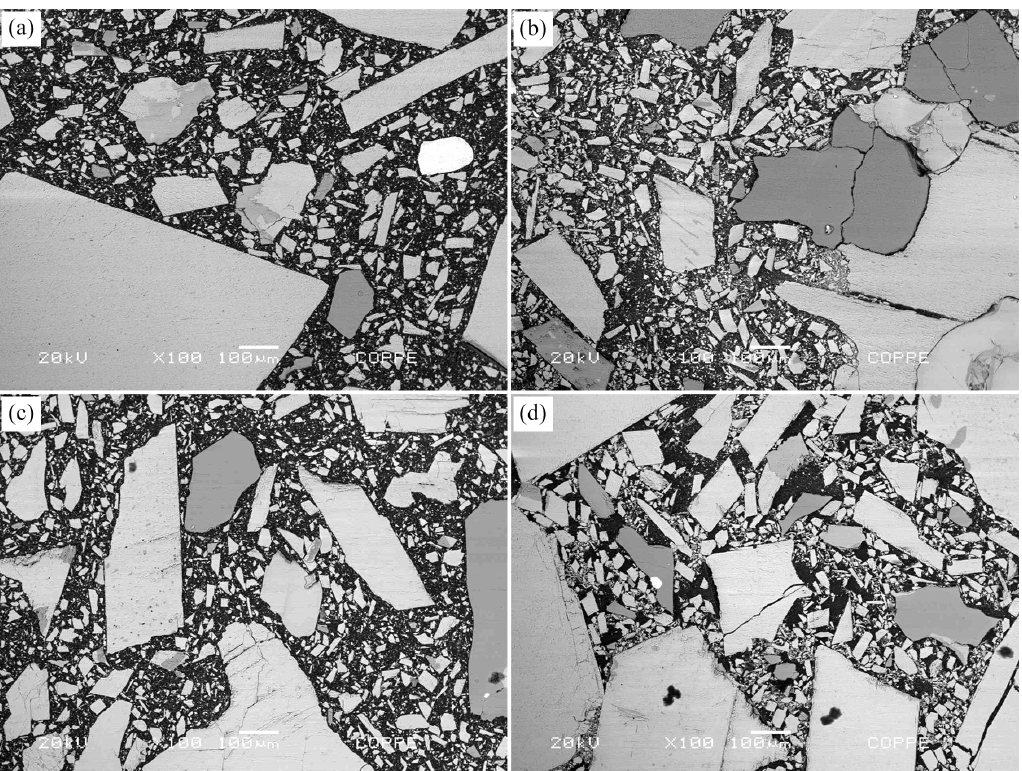
Figure 6. Polished cross section of AM1 (a); AM2 (b); AM3 (c) and AM4 (d). Magnification 100 X.